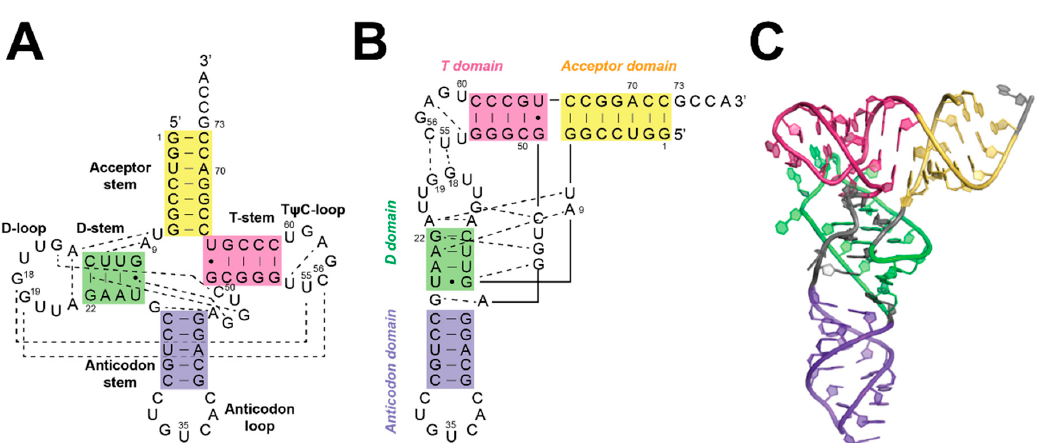
15 of 29 Figure 8. Proposed transition state structure of the catalytic mechanisms of ( A ) bacterial RNase P (as proposed in [22]) and ( B ) At PRORP1 (adapted from [110]).